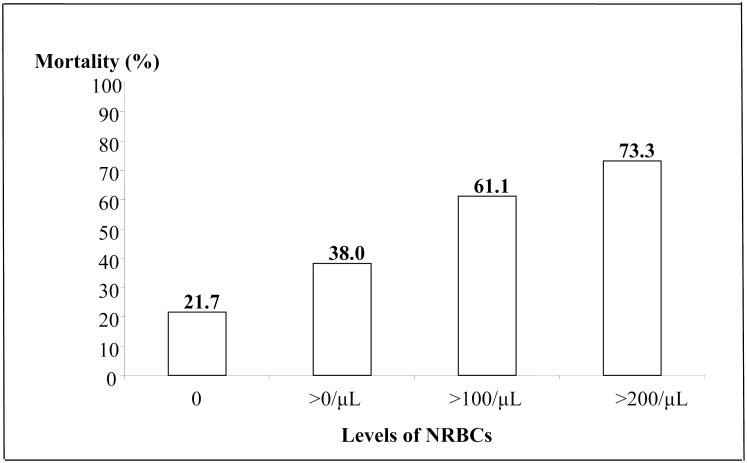
Mortality of ICU patients in relation to concentrations of nucleated red blood cells (NRBCs) P<0.001.